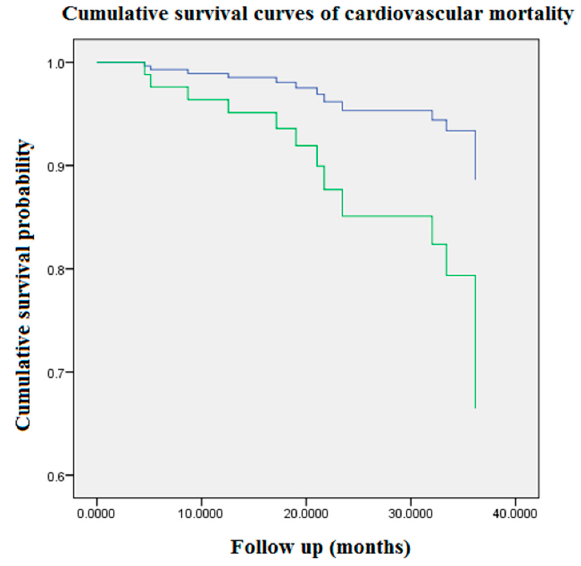
Figure 2. Cumulative event-free survival curves of cardiovascular mortality with respect to pre- dialytic SpO2 after adjusting for OSA, albumin, diabetes, and prior history of CAD during 2152.8 patient-months of follow up. The green line indicates MHD patients with abnormal levels of SpO2 (<95%), and the green line indicates MHD patients with normal levels of SpO2 (95–100%). CAD = coronary artery disease; OSA = obstructive sleep apnea; SpO2 = pulse oximeter saturation.